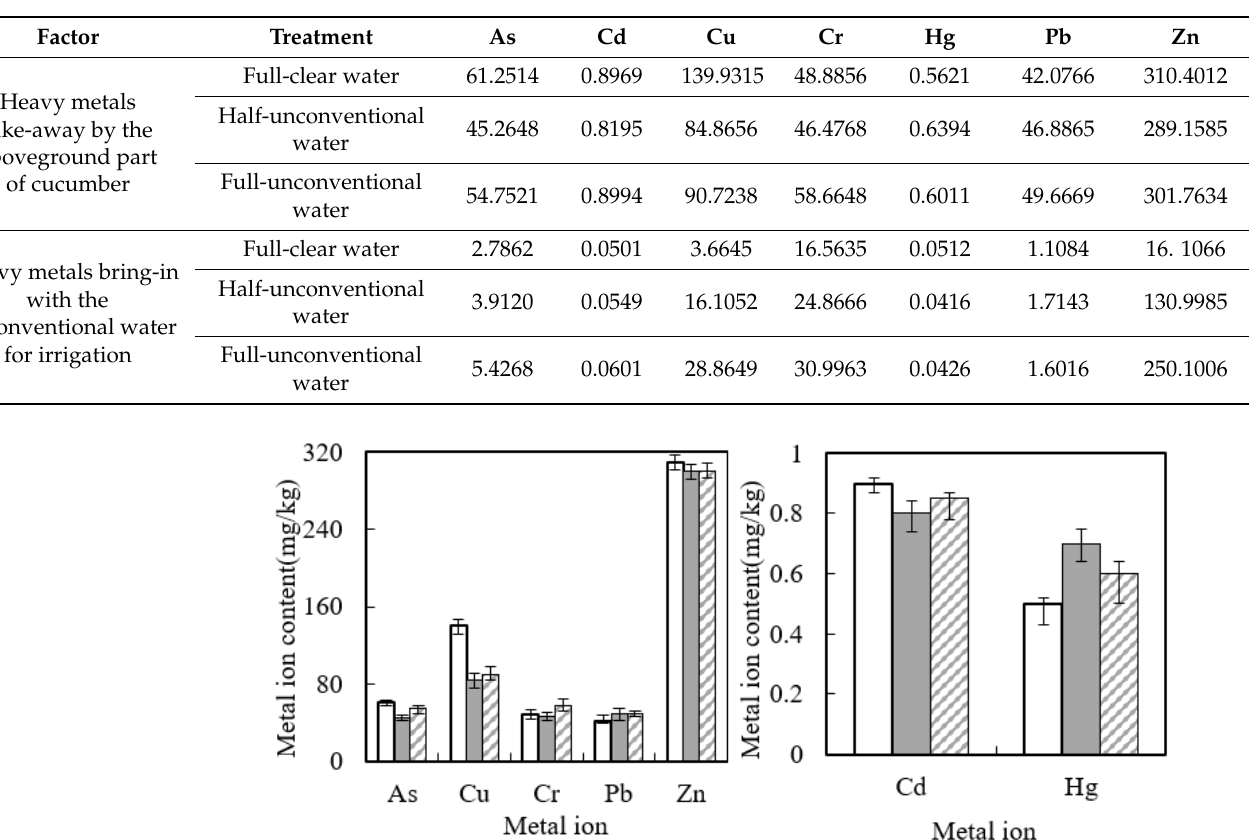
Table 5. During the cucumber growth season, changes of heavy metals in soil before and after cucumber harvest. mg/kg.